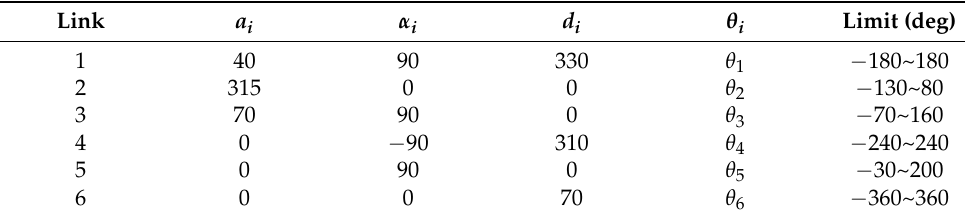
Table 1. The DH parameter of the SR4C robot.